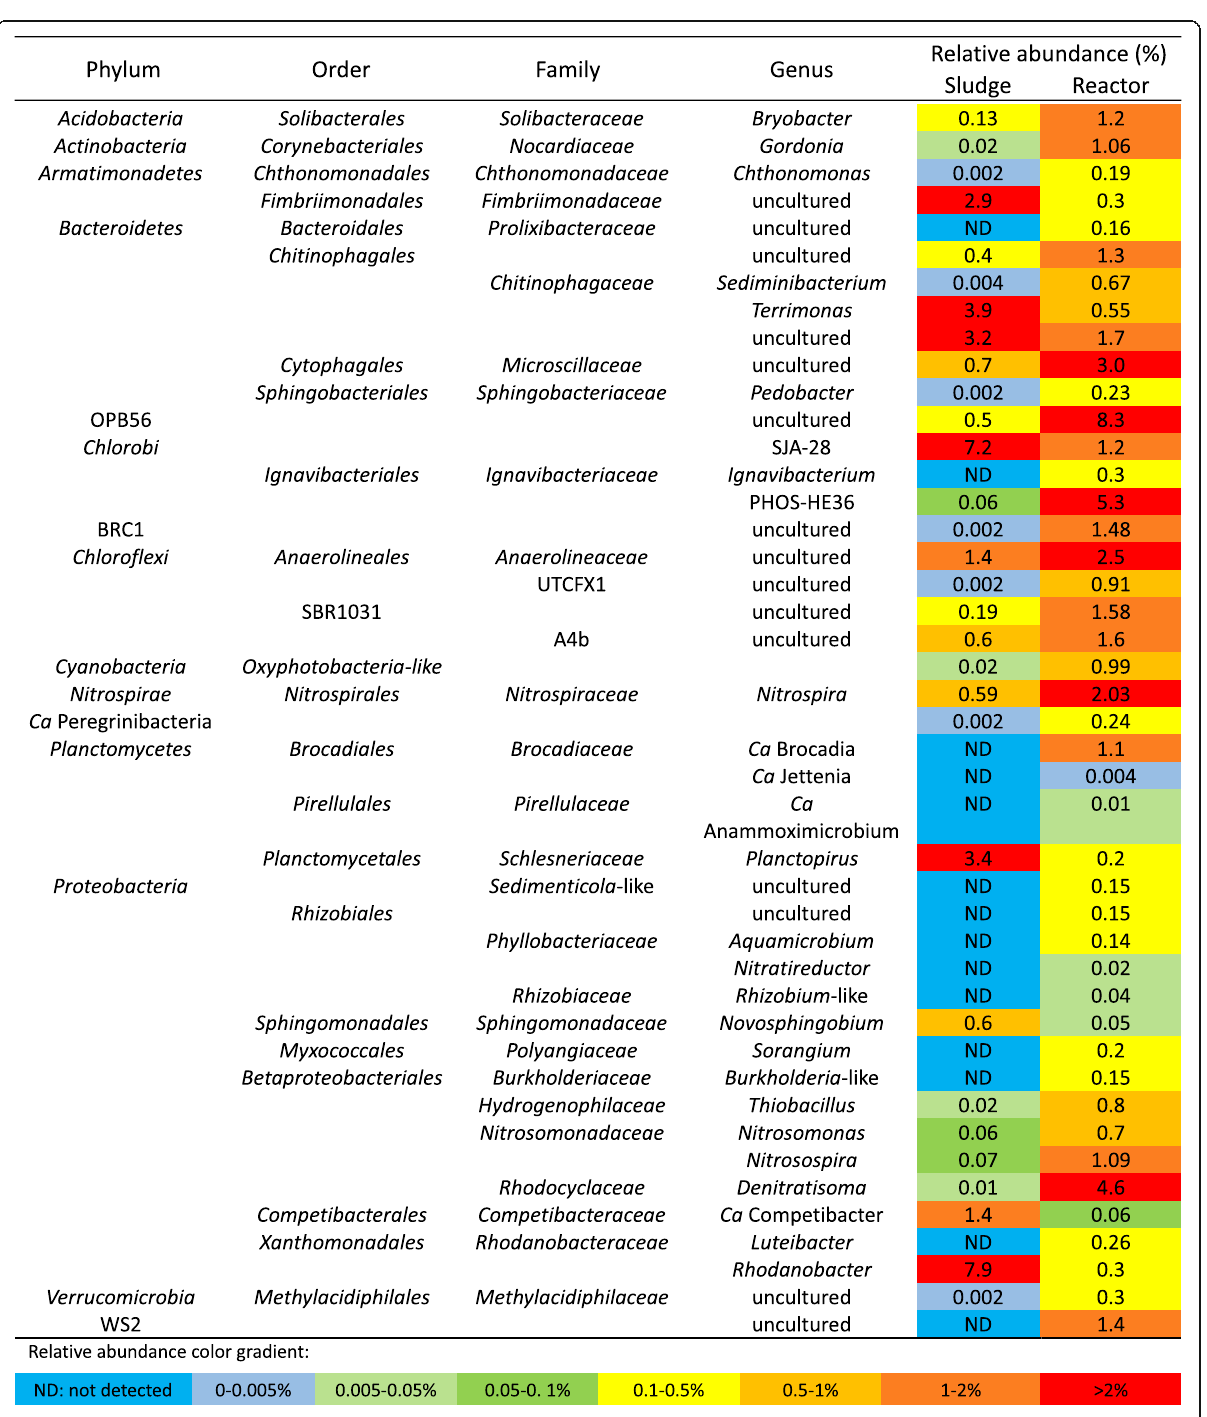
Fig. 4 Relative abundance percentage at the lower taxonomic level of the most abundant taxa, and with major noticeable shifts (an order of magnitude and/or more than 0.5%), in the sludge seed (day 0) and after the start-up period (day 397). Colorimetric scale (below) represents increasing percentages of the relative abundance of